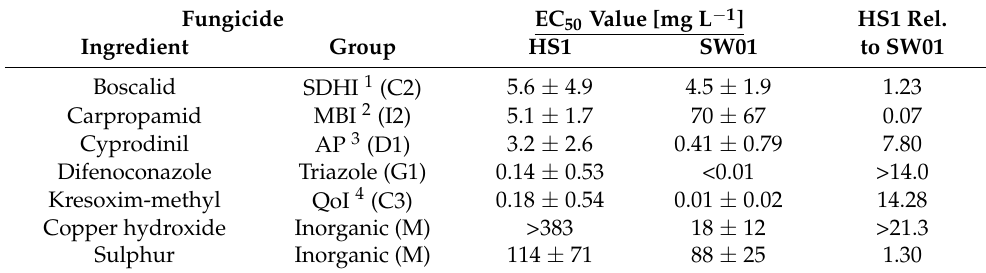
Table 5. Sensitivity of the melanin-deficient-isolate SW01 of Venturia inaequalis to fungicides differing in the mode of action as compared to the wild-type isolate HS1. Evaluation of leaf scab (average of leaf levels 1 to 7), 12 d p.i. (n = 4). Mean disease intensity of non-treated plants was 20.7 % and 13.2 % for HS1 and SW01,